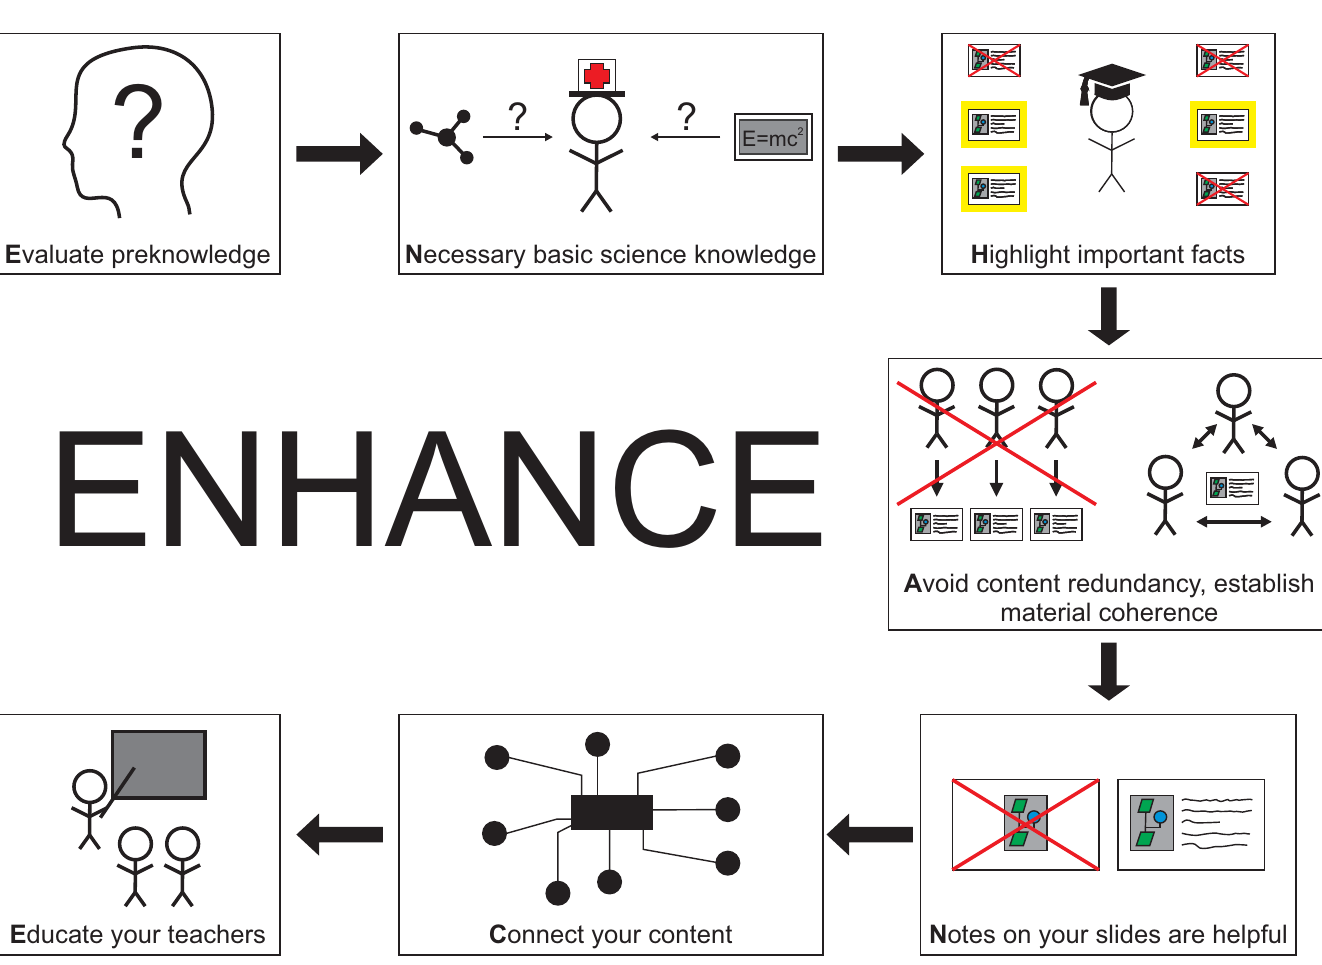
Fig 1. This figure shows the seven steps of the ENHANCE